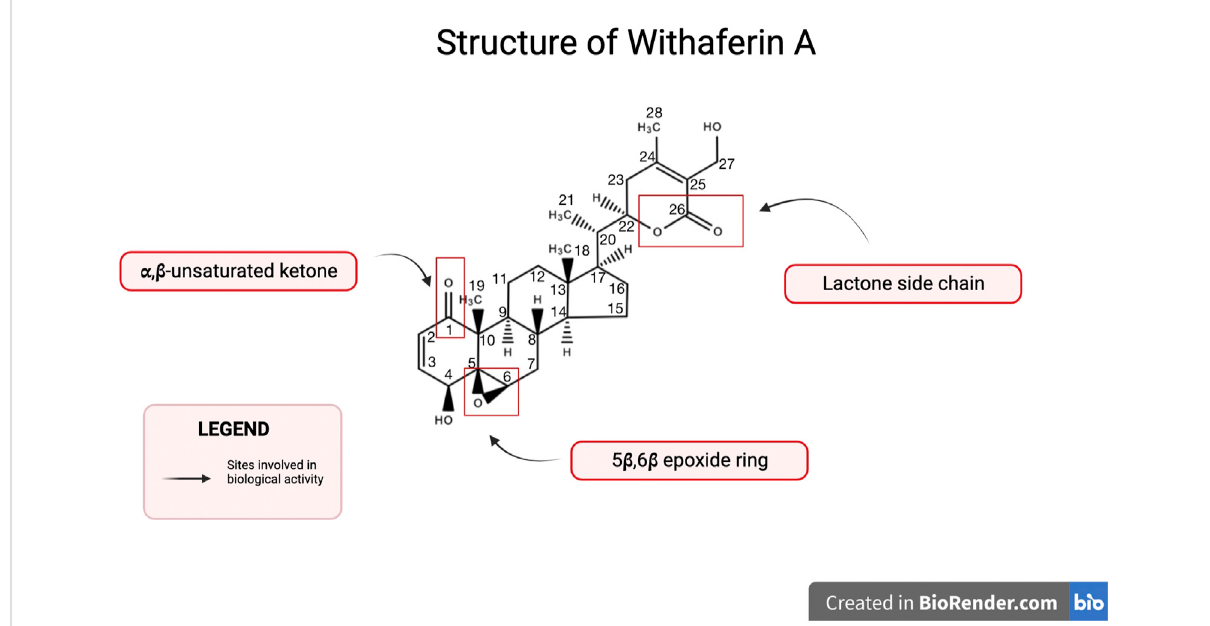
FIGURE 1 Structure ofWithaferin A.Withaferin A isaC28 steroidal lactone with substituentsimportant for biological activity. Notablesubstituentsinclude a 5 β ,6 β epoxide ring, a lactone side chain, and an α , β -unsaturated